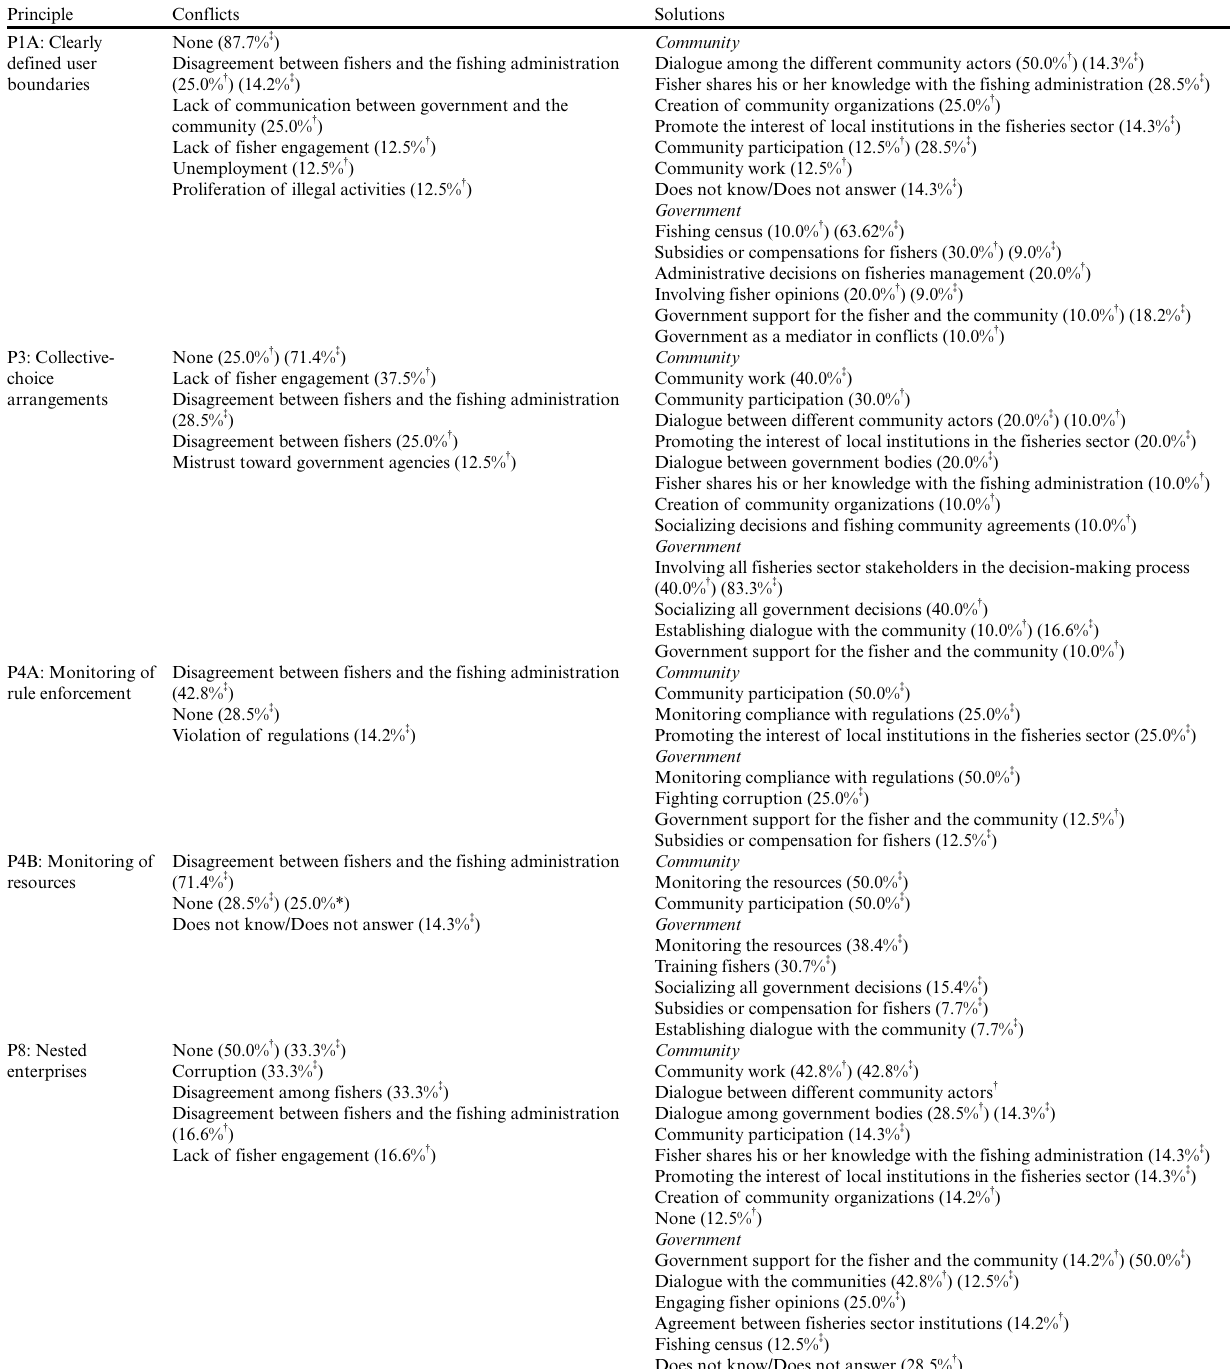
Table 8. Conflicts and solutions to advance the principles identified as priorities by the small-scale marine fishers of two communities in